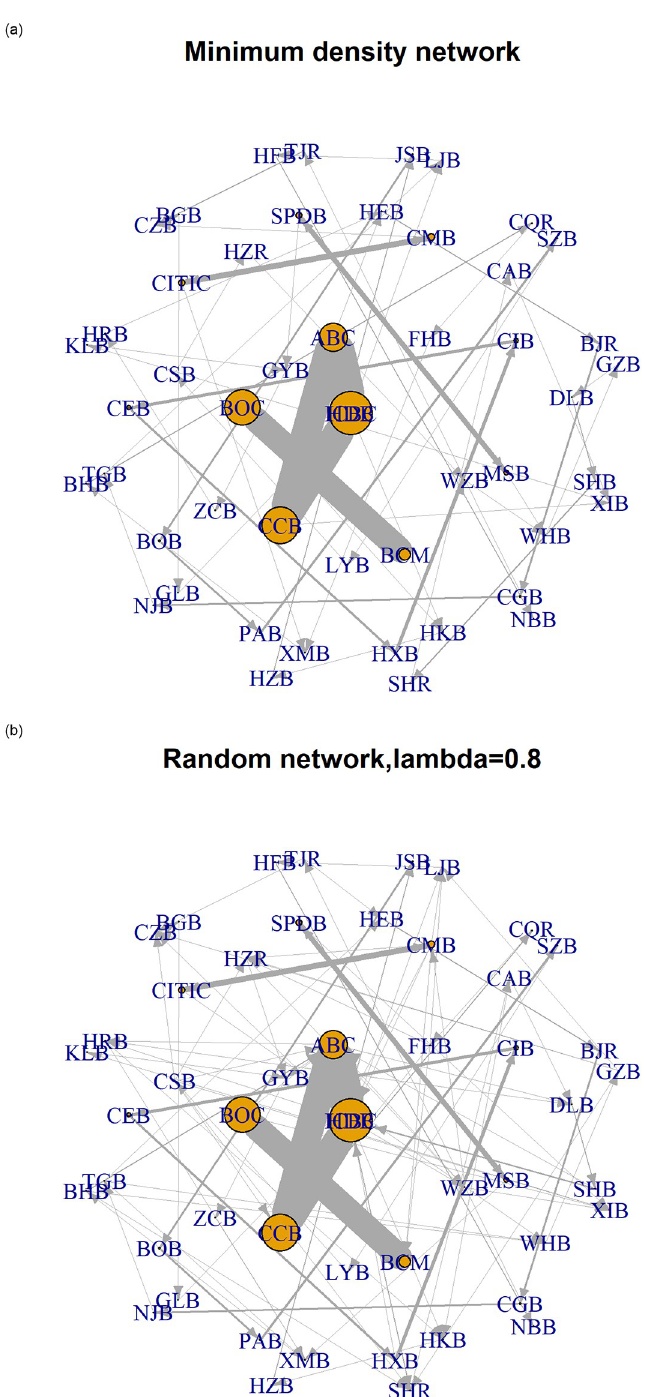
Fig 5. Interbank exposure network in 2010 with the closest matching and random matching. Bank equity determines the nodes’ size of the network, and the amount of interbank lending/borrowing determines the thickness of the gray lines linking the nodes. The node names are listed in Table S1 of Appendix C in S1 File.